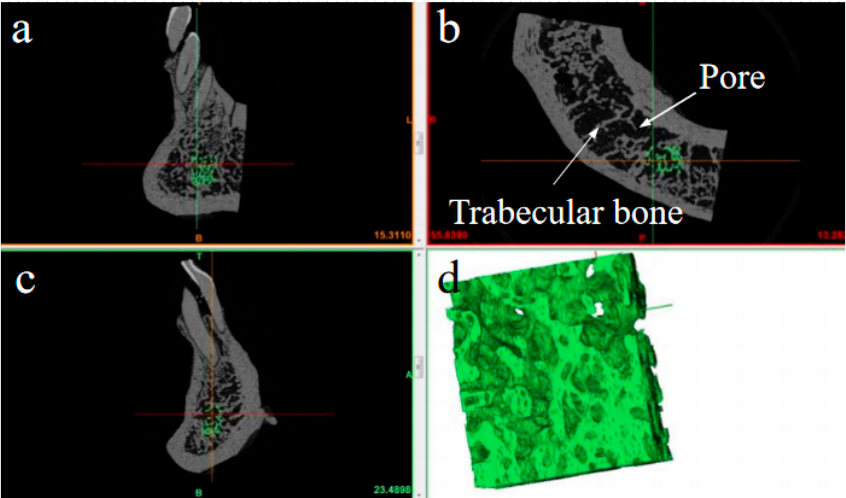
Figure 3. Structure of CBAB under micro CT. ( a – c ) Micrographs of periodontal tissue from different perspectives; ( d ) the reconstruction map of CBAB.